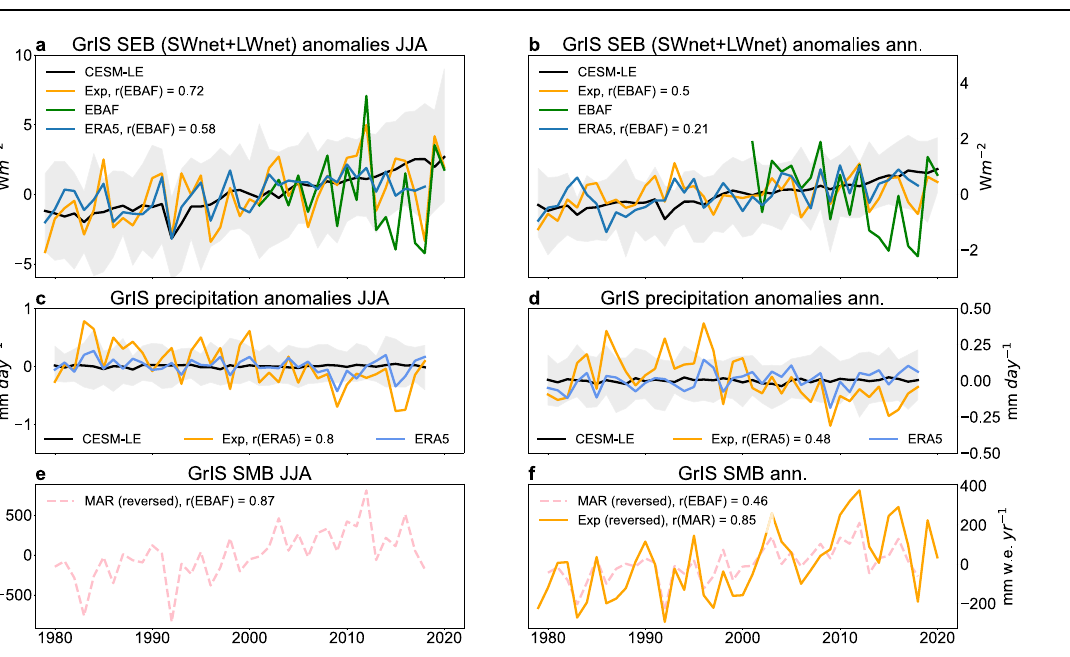
experiment (Exp, orange) and the CESM-LE (grey shading and black line for the ensemble mean) GrIS spatial-averaged precipitation for c JJA and d the annual means. Panel e shows the MAR-simulated GrIS surface mass balance (SMB) anomaliesforJJAalongwith f showingthecomparisonofannualSMBbetweenMAR andthenudgingexperimentinvolvingCISM-Glimmer.Inthelegends, ‘ r() ’ indicates the correlation coef fi cients between the corresponding variableand the one in the